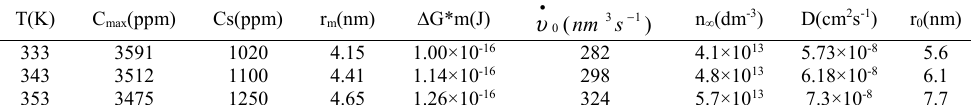
Table 2. The nucleation and growth effective parameters of TiO